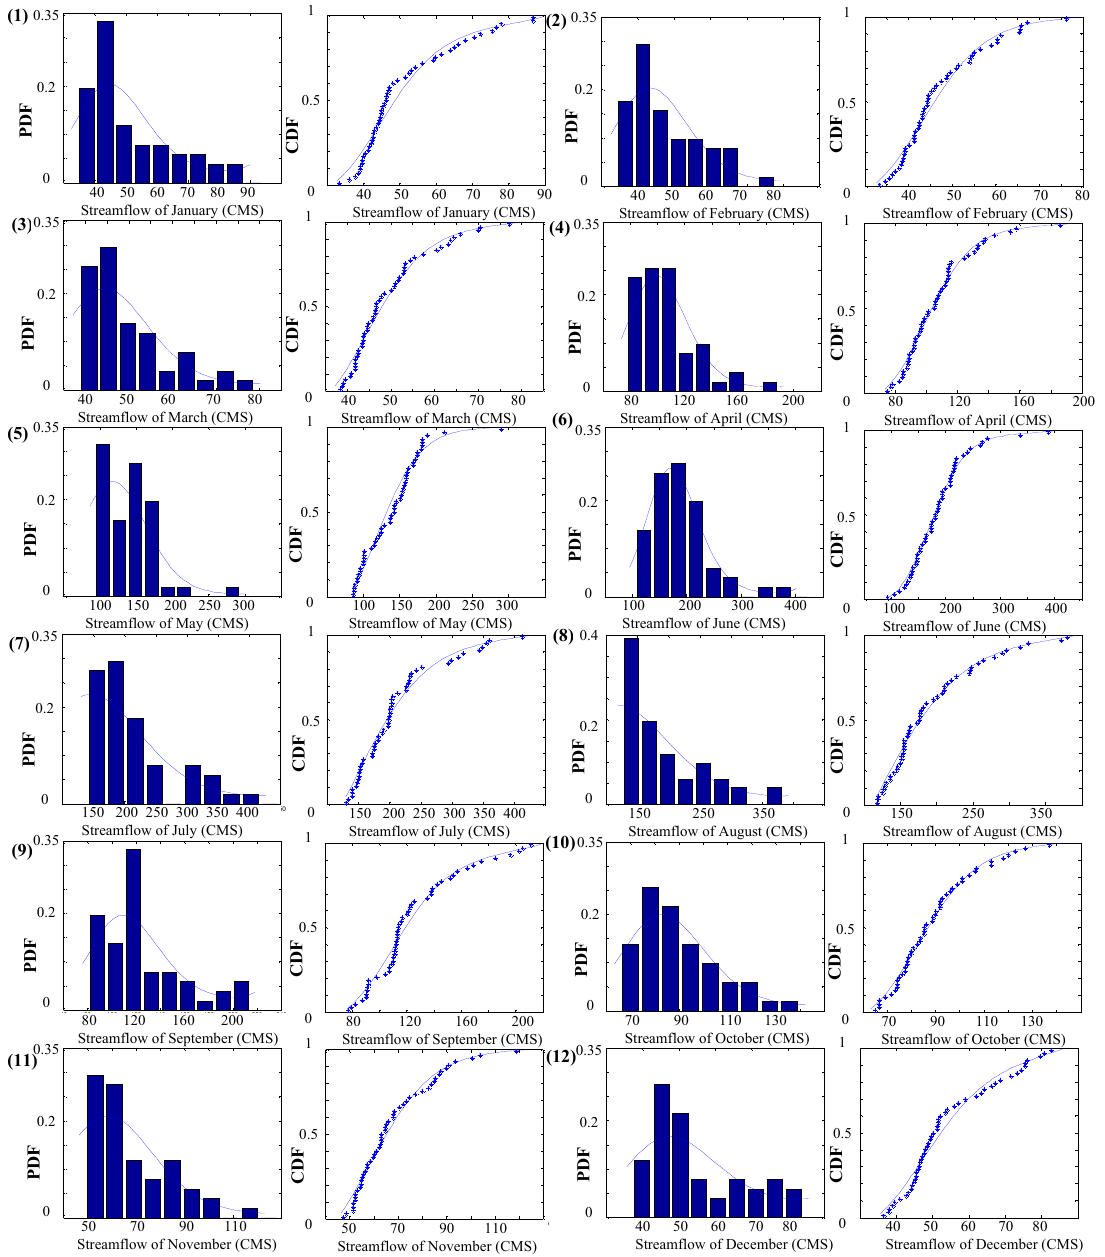
Figure 4. Comparison of theoretical and empirical marginal probability density function (PDF) and cumulative density function (CDF). The values are calculated monthly from 1957 to 2009. The abscissa represents streamflow values. The corresponding size varies from month to month. PDF describes the output of variables, and indicates the frequency at a given streamflow value. CDF describes the integrate of PDF, and indicates the probability of a given streamflow value. Lines in PDFs and CDFs show the performance of generated values. Bars and dots depict the empirical values in PDFs and CDFs, respectively.